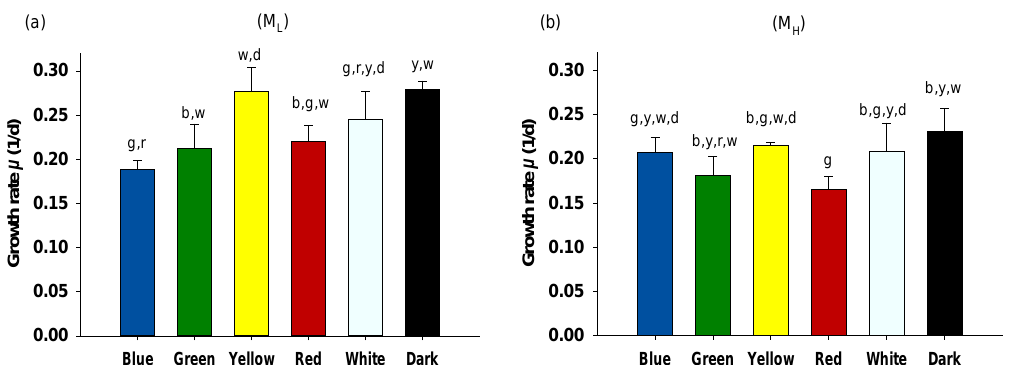
Figure 2. Growth rates of A. protothecoides cultivated mixotrophically for seven days with different light wavelengths: ( a ) with low peptone (M L ) and ( b ) with high peptone (M H ). Each bar represents the average ± SD of n = 3 replicates. The letters (b: blue, g: green, y: yellow, r: red. w: white, and d: dark) indicate that there were no statistically significant differences between the means (two-way ANOVA; Duncan method; p < 0.05) of the pairwise comparisons between the different wavelengths. Between the variable groups M L and M H there were statistically significant differences ( p < 0.01).